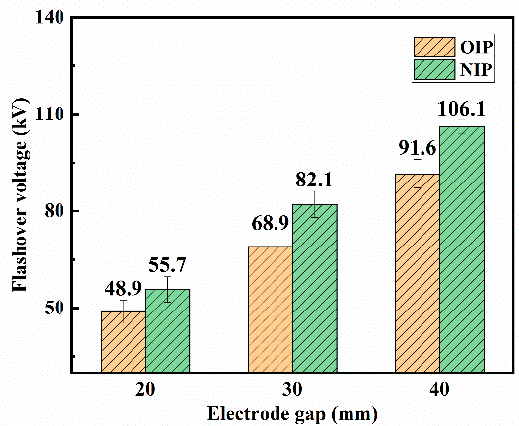
Figure 5. Creeping flashover voltage of the oil-impregnated pressboard (OIP) and the nanofluid-impregnated pressboard (NIP) under positive lightning impulse voltages.